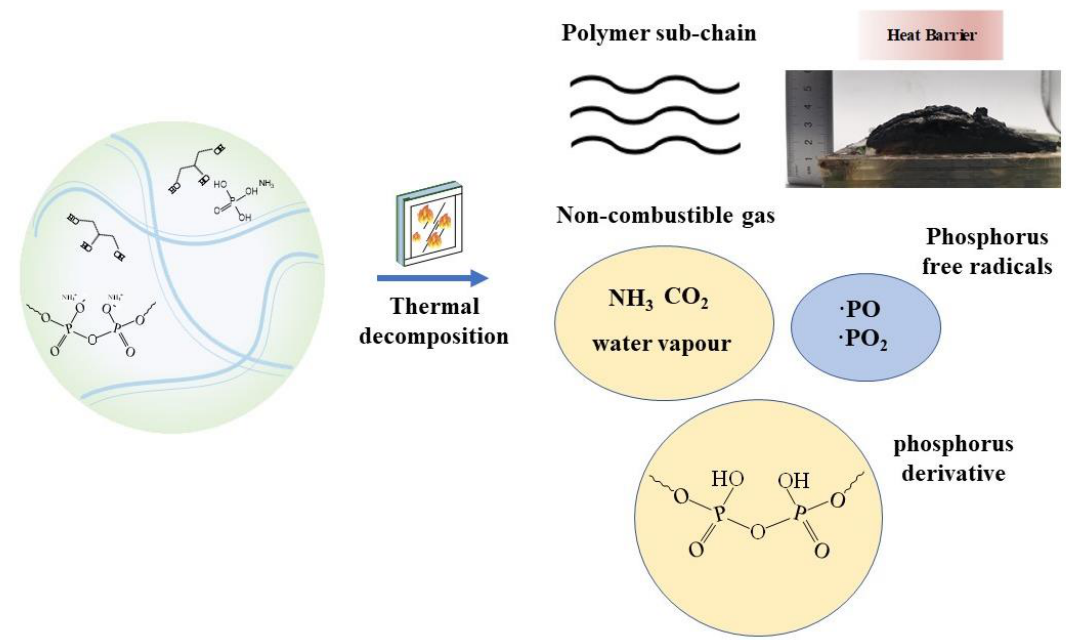
Figure 7. Fire retardant mechanism of the transparent flame-retarded hydrogel based on P(AM-co- MAA) applied in the fire-resistant glass.